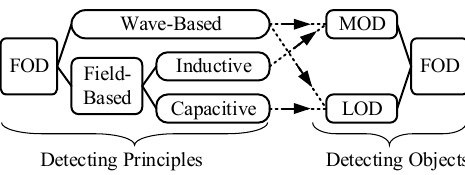
Figure 1. Category of foreign object detection (FOD), metal object detection (MOD) and living object detection (LOD) technology.